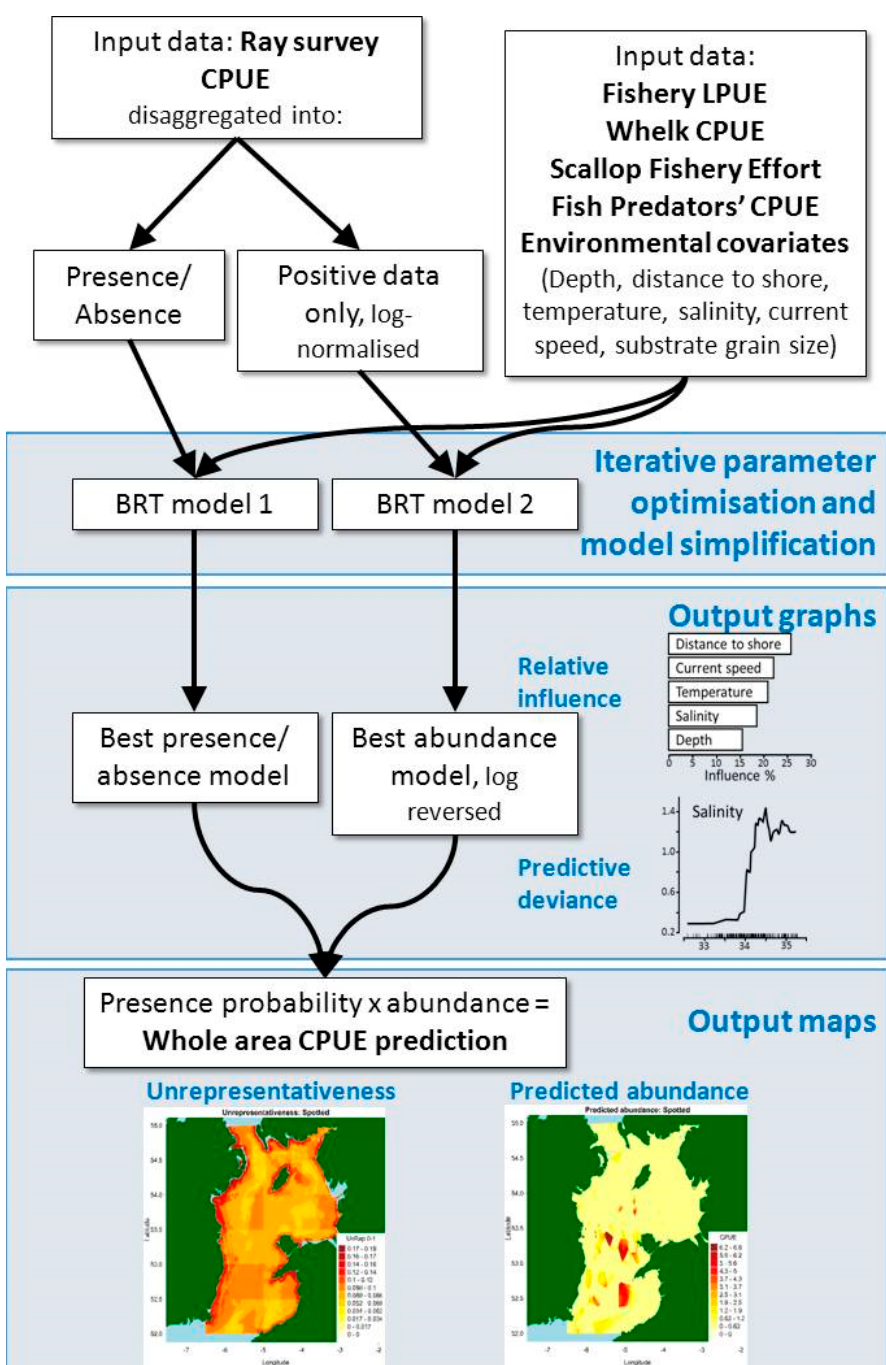
Figure 5. Conceptual diagram of delta log ‐ normal boosted regression tree modeling approach.